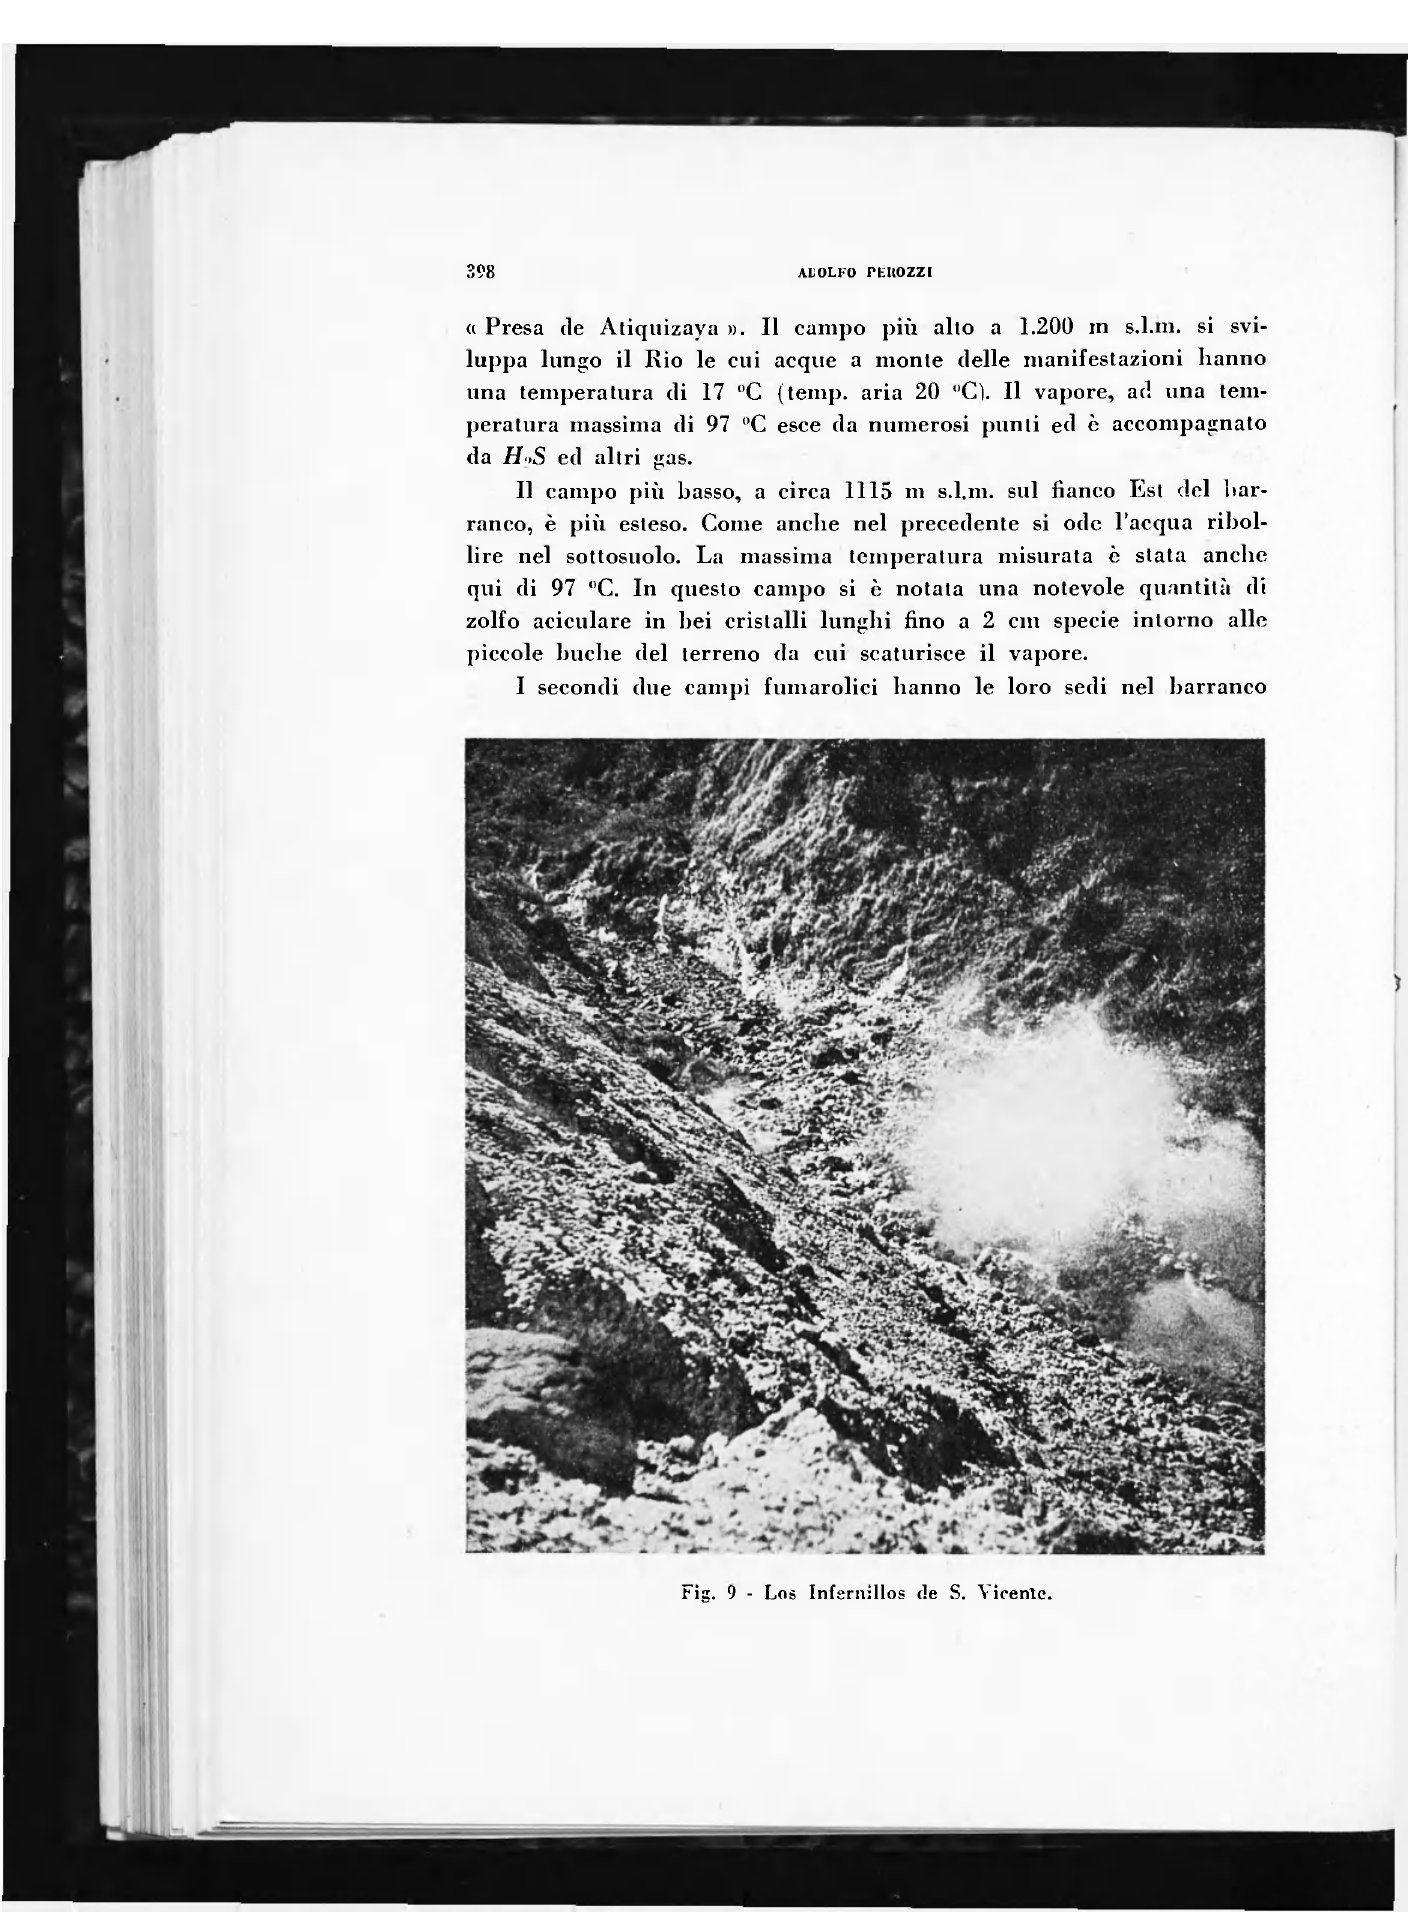
Fig. 9 - Los Infarnillos de S.